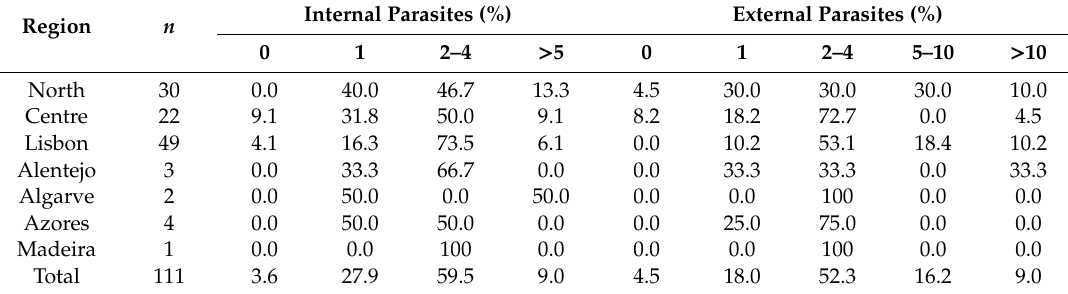
Table 4. Husbandry of Portuguese number of yearly preventive treatment for internal and external parasites.